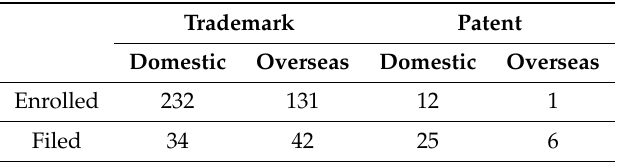
Table created by the authors, Source: [18].